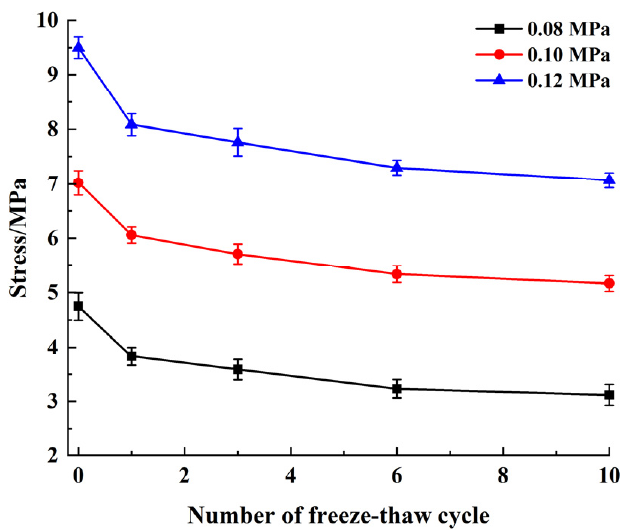
Figure 6. Effect of freeze–thaw cycles on sample strength.